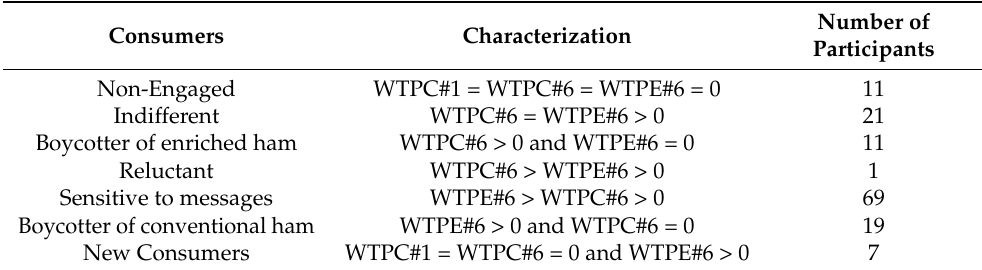
Table 2. The number of participants with specific